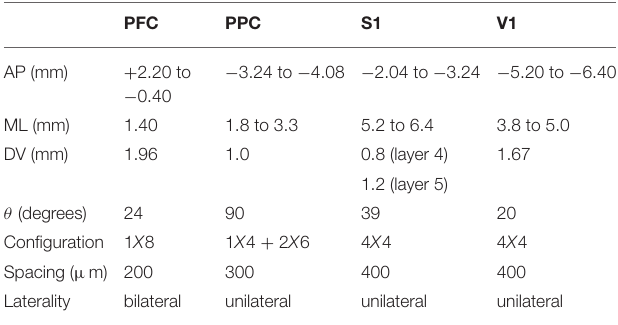
TABLE 1 | Steriotactic coordinates and arrangement of arrays used in the tactile discrimination